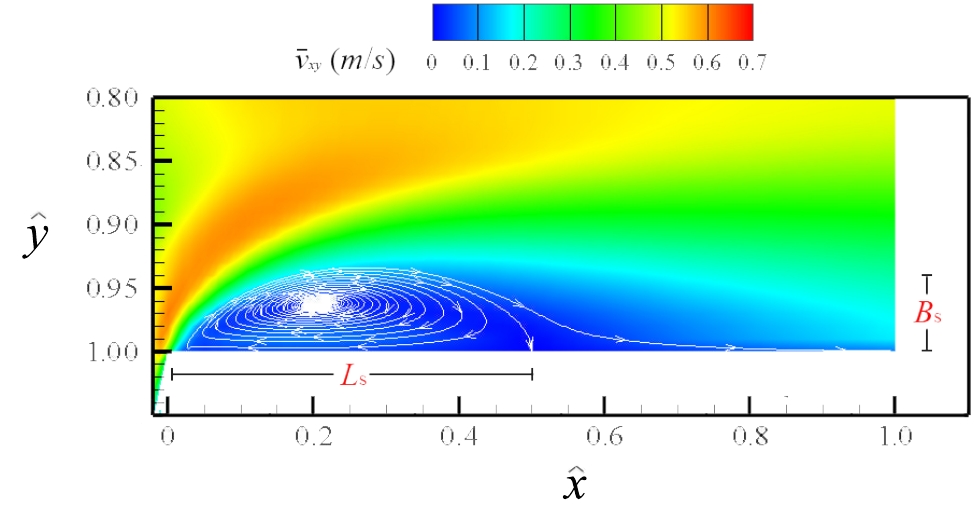
Figure 11. Time-averaged velocity ¯ v xy in the horizontal plane ˆ z ∼ 0.5 for α equal to 70 ◦ . Here, ˆ x = x / B m is the non-dimensional abscissa directed in the streamwise direction centred in the downstream corner of the